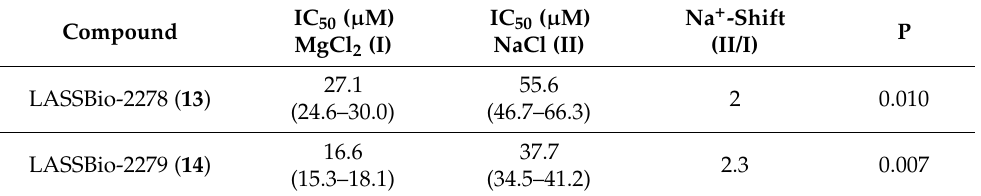
Table 3. Affinity and intrinsic efficacy of retroisosteric compounds 13 and 14 at the A 2A R present in membrane preparations from rat striatum. Average curves of three independent experiments (in triplicate) were analyzed by non-linear regression to estimate the IC 50 values with their 95% confidence interval (95% CI). For each compound, the Na + -shifts were calculated by dividing the IC 50 value obtained in the medium containing Na + by the IC 50 value obtained in the medium containing Mg 2+ and statistically analyzed by paired t test on log IC 50 values ( P